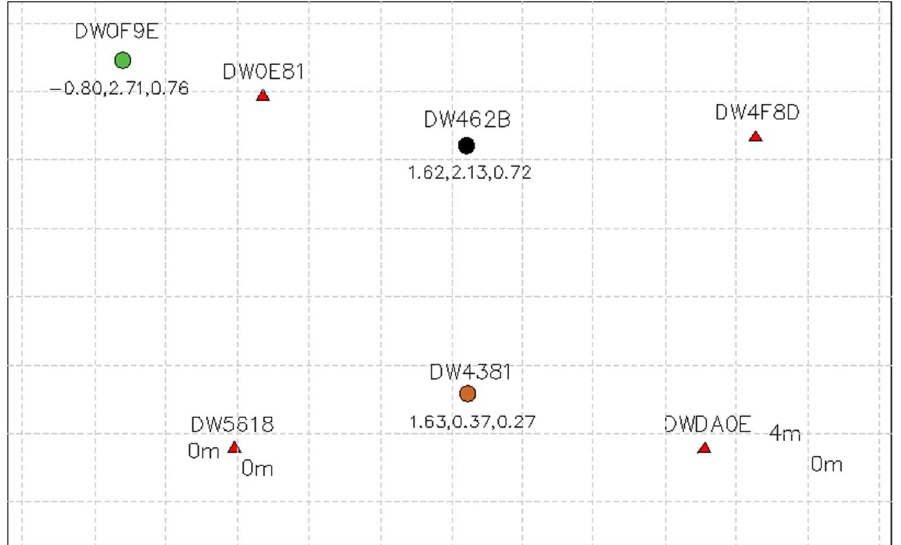
Figure 3. Sensor data consisting of four anchors (red triangles), 2 parallel targets (brown and black dot in between triangles) and one moving target (green dot at the top left). The numbers shown beneath the symbols are the coordinates of the sensors in 3D (x, y, z-axes) with the initiator anchor at the bottom left with (0,0,0) coordinates.